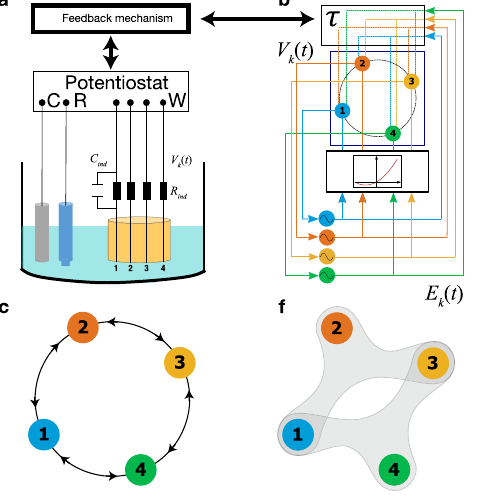
is implemented by storing the past data in the memory of the computer.) c Representation of the in a ring network topology used in the experiment. d Electrodepotentialtime series. e Filtered and fi tted (darkred line)instantaneous frequency using LASSO for hypernetwork reconstruction corresponding from top to bottom to oscillators 1 to 4, respectively. f Experimental recovery of the phase interactions given by a